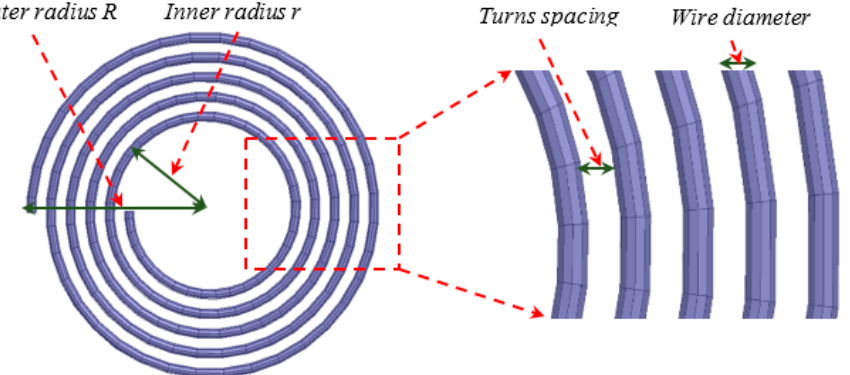
Figure 13. Illustrative shape of a circular planar coil.